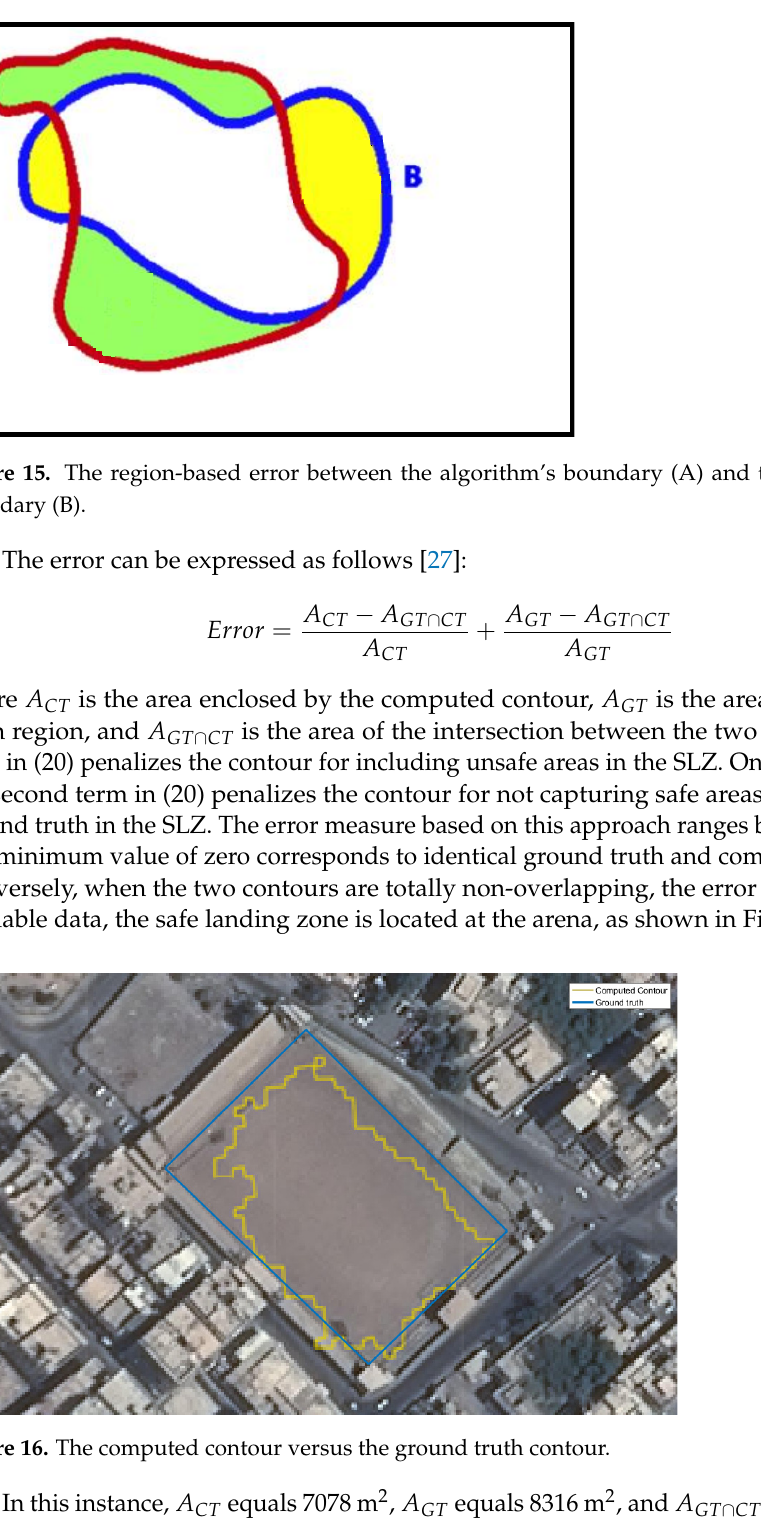
Figure 16. The computed contour versus the ground truth contour.